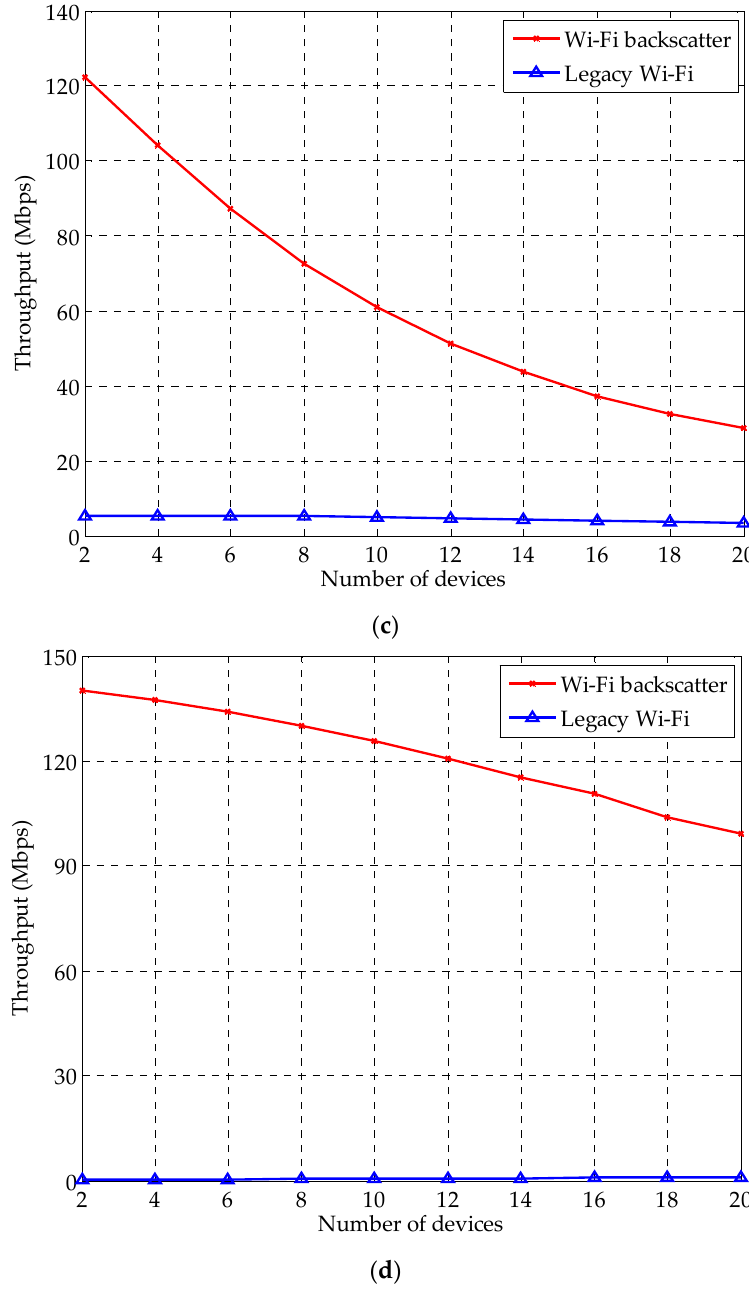
Figure 6. Variation of throughput for separate cases: ( a ) reduced CW min = 15; ( b ) reduced CW min = 7; ( c ) reduced CW min = 3; and ( d ) reduced CW min = 1.